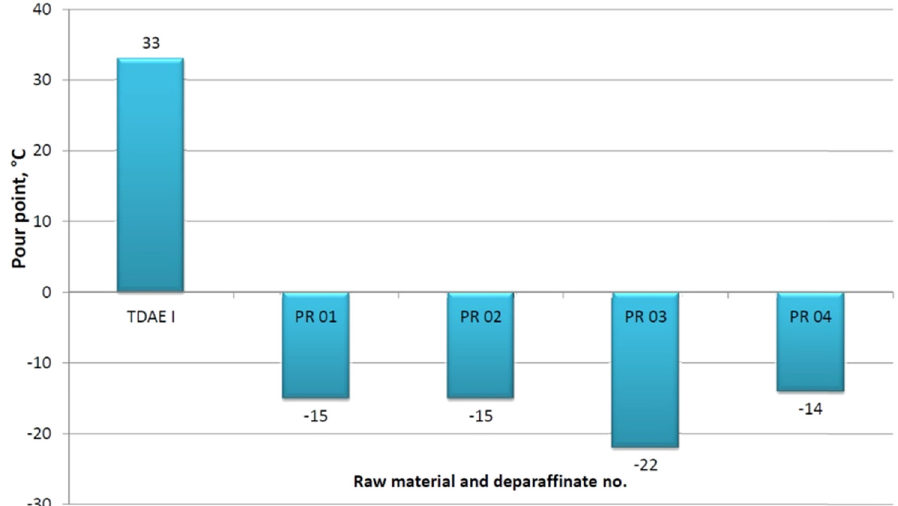
Figure 3: E ff ect of the dewaxing process with the MEK – TOL solvent on the change of the depara ffi nate pour point – TDAE I raw